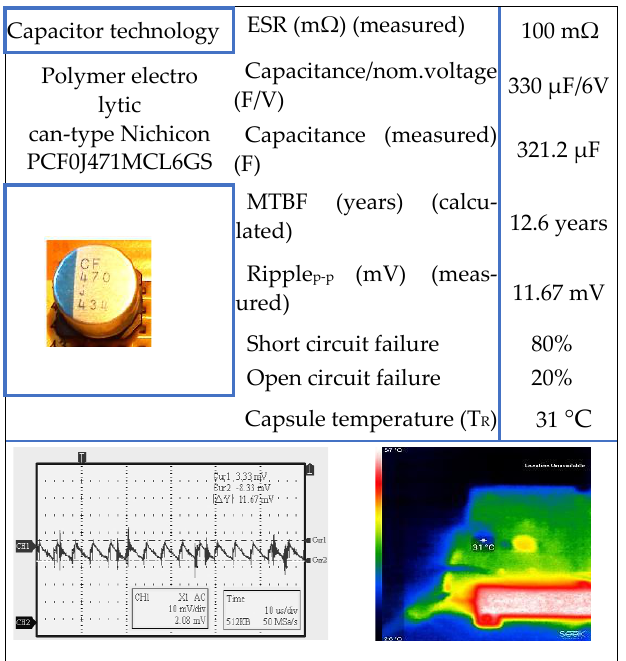
Figure 10. Data taken from measurement, photo of aluminum electrolytic capacitor type OMNI 470/25V (−40 °C +105 °C) as DUT (left– center), the actual the ripple’s waveform (left) and surface capacitor’s temperature which is required in reliability calculation (right).